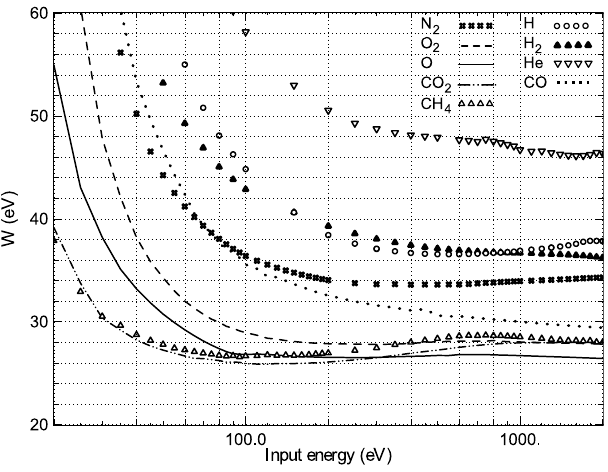
Fig. 3. W net values for single constituent atmospheres: N 2 , O 2 , O, CO 2 , CO, CH 4 , H, H 2 and He.